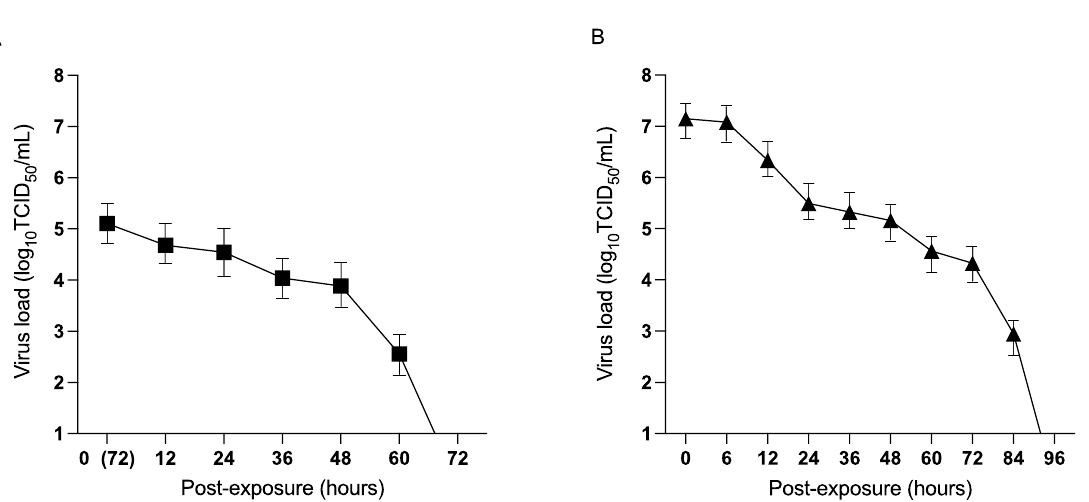
Figure 1. Persistence of H9N2 AIV in feces: ( A ) represents the persistence of H9N2 AIV in feces from infected chickens in model A. On day 14 of age, seeder chickens in model A were inoculated with H9N2 AIV via direct inoculation or PBS (control), respectively ( n = 10). Seeder chickens were held for 3 days post-infection (PI) and then removed without disturbing the internal settings of the isolator. A group of healthy naïve chickens ( n = 10) were then exposed to the feces from the seeder chickens. Fecal samples were collected immediately after the addition of the exposed chickens in the isolator (0 h PE). The collected samples were placed in petri dishes within the Horsfall units. Samples were taken from the collected fecal droppings and assessed for virus load every 12 h starting from 0 h PE. ( B ) represents persistence of H9N2 AIV in experimentally spiked fecal droppings in model B. Fecal samples from healthy uninfected chickens ( n = 10) were collected and experimentally spiked with H9N2 AIV. The inoculum was deposited in different areas of the Horsfall units. Fecal samples were collected from the deposited inoculum immediately after the introduction of the exposed chickens (0 h PE). Virus load (log 10 transformed) in the experimentally spiked fecal droppings was assessed every 12 h starting from 0, 6 h PE. Virus load (log 10 transformed) in the fecal droppings in both the models was assessed based on TCID 50